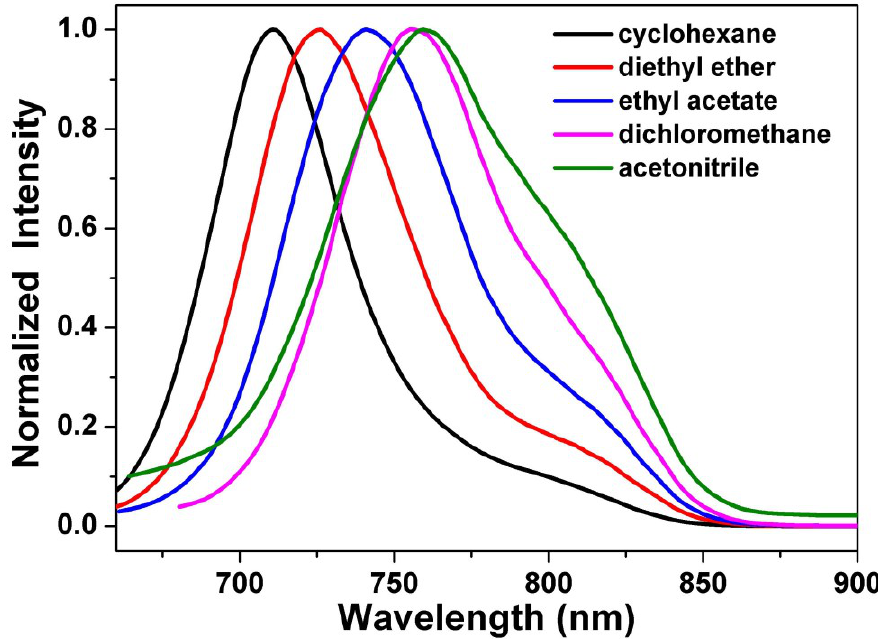
Figure 4. Normalized emission spectra of 1a in various solvents.